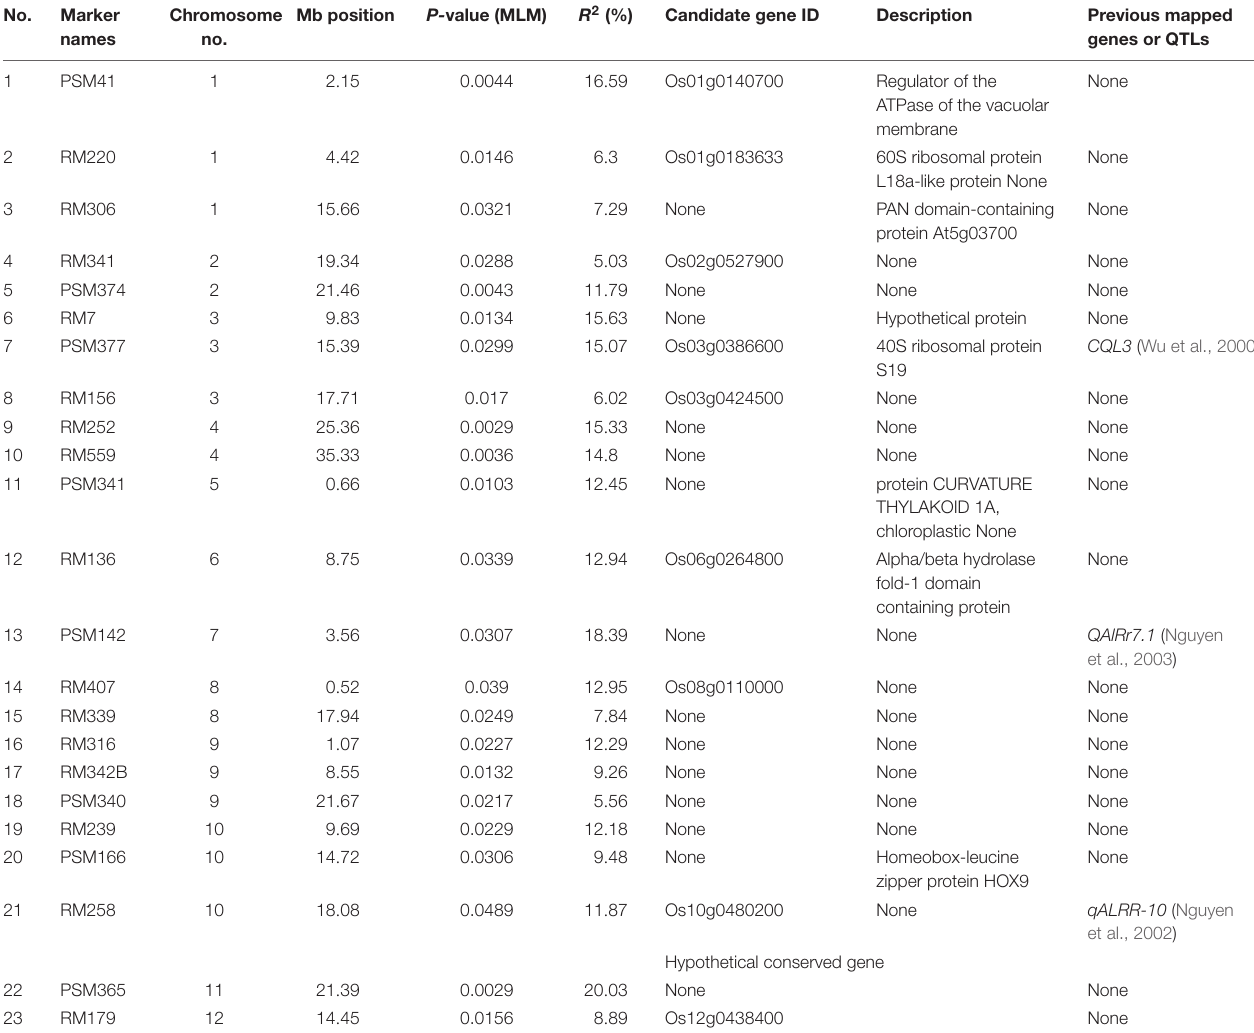
TABLE 2 | Significant ( P < 0.05) associations between SSR markers and aluminum tolerance.